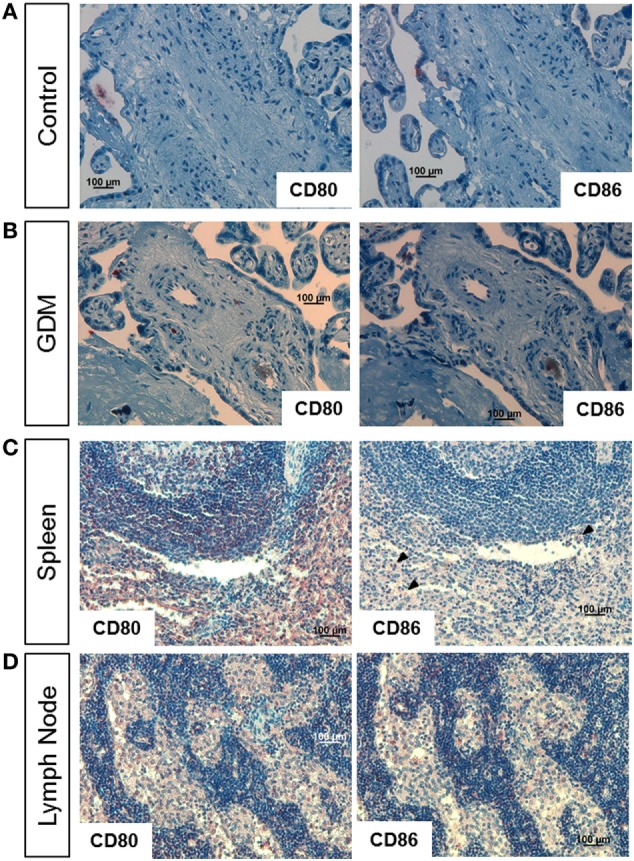
Immune histochemical assessment of M1 macrophage markers in placental tissue. (A) Staining of control placental tissue against CD80 (left) and CD86 (right). (B) Staining of gestational diabetes mellitus (GDM) placental tissue against CD80 (left) and CD86 (right). (C) Staining of human spleen against CD80 (left) and CD86 (right, arrow heads indicate positive cells). (D) Staining of human lymph node against CD80 (left) and CD86 (right). Pictures are representative of serial sections from four different placentas per group; spleen and lymph node tissue served as positive controls.